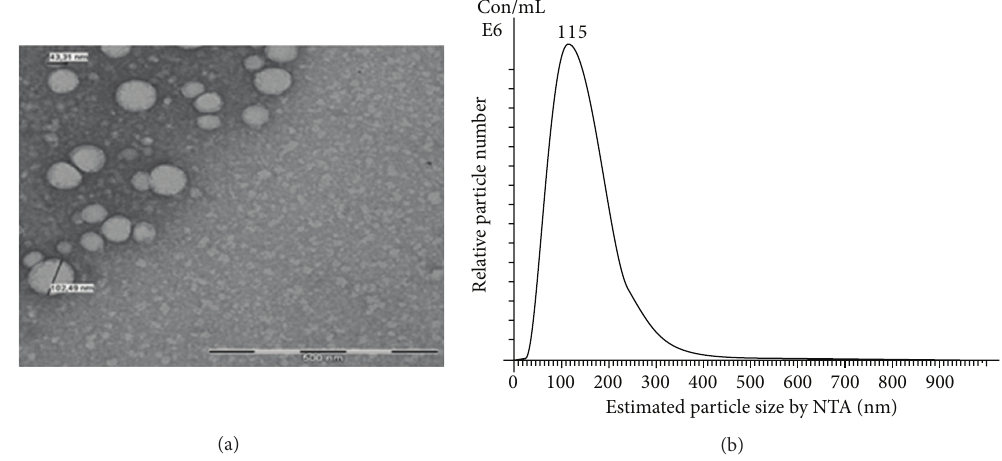
Figure 2: Characteristics of exosomes isolated from the MSCs [27]. (a) Representing exosomes identified by the transmission electron microscopy (TEM); the size ranges from 40 to 120nm, scale bar 500 nm. (b) Showing the distribution of diameters of exosomes measured by the Nanosight (NTA). The most common diameter was around